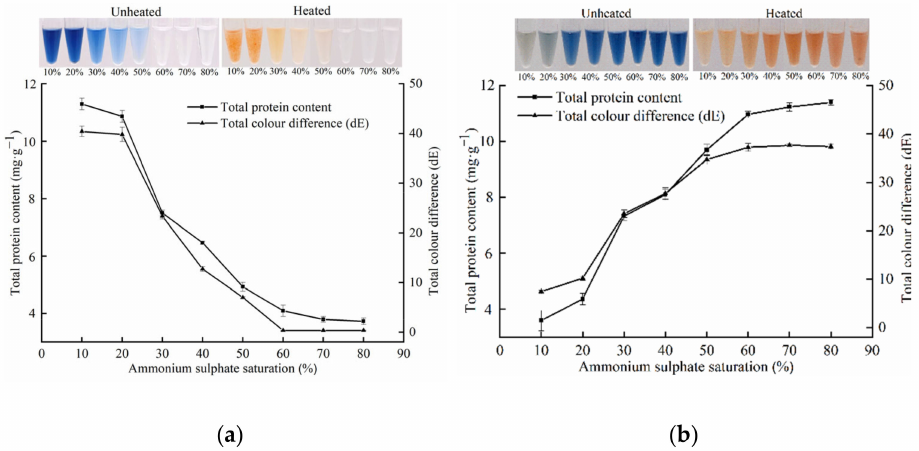
Figure 1. The ammonium sulphate curve of the red-change-related primary pigment proteins: ( a ) the supernatant, ( b ) the precipitate.